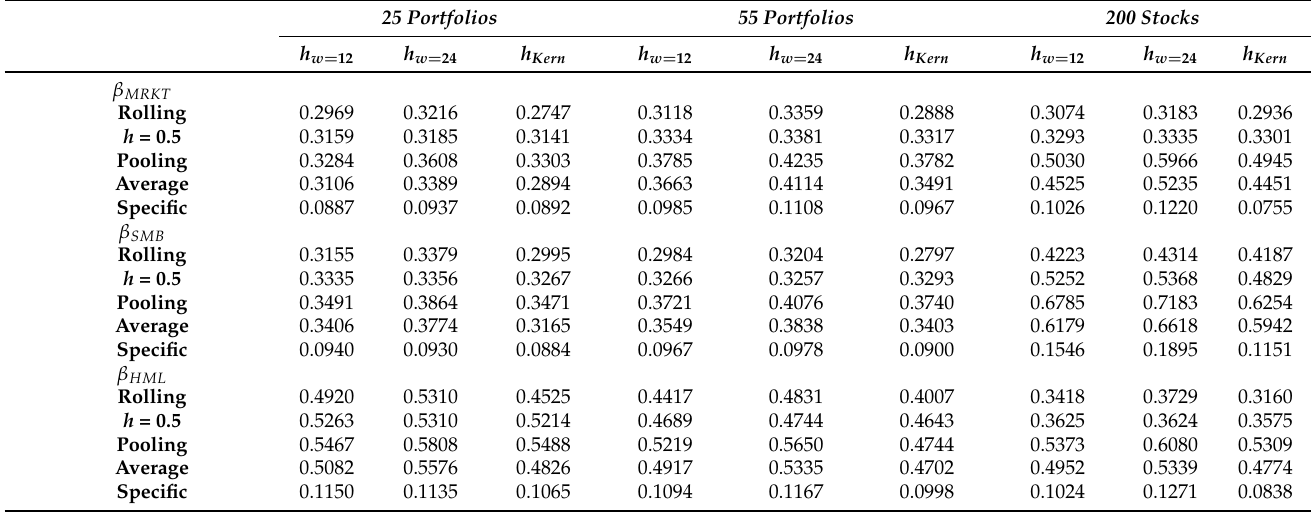
Table 7. Correlation matrix among factor risk